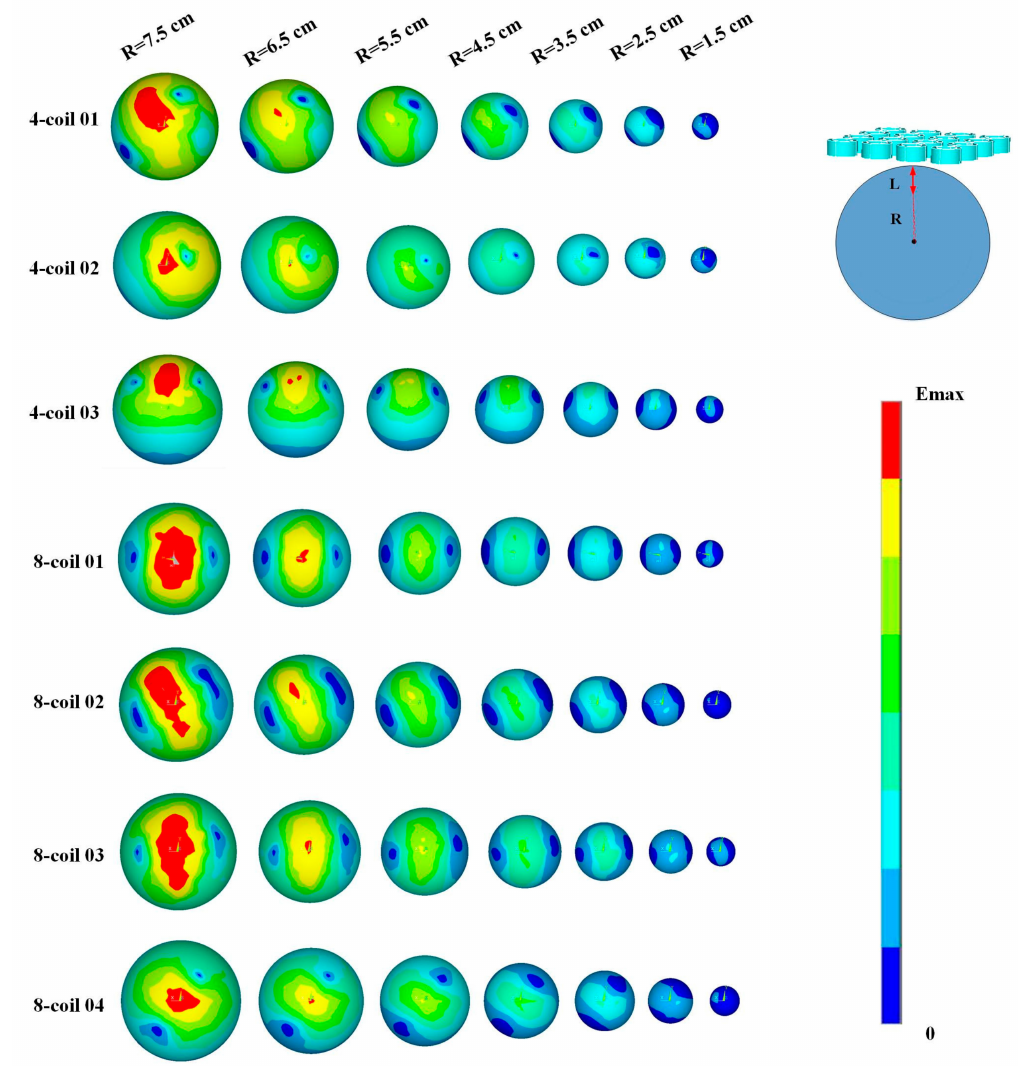
Figure 8. Spatial distribution of the induced EF in different layers of the head model. R meets the relationship of “R = 8.5- L ”, indicating that R attenuates with the increase of L